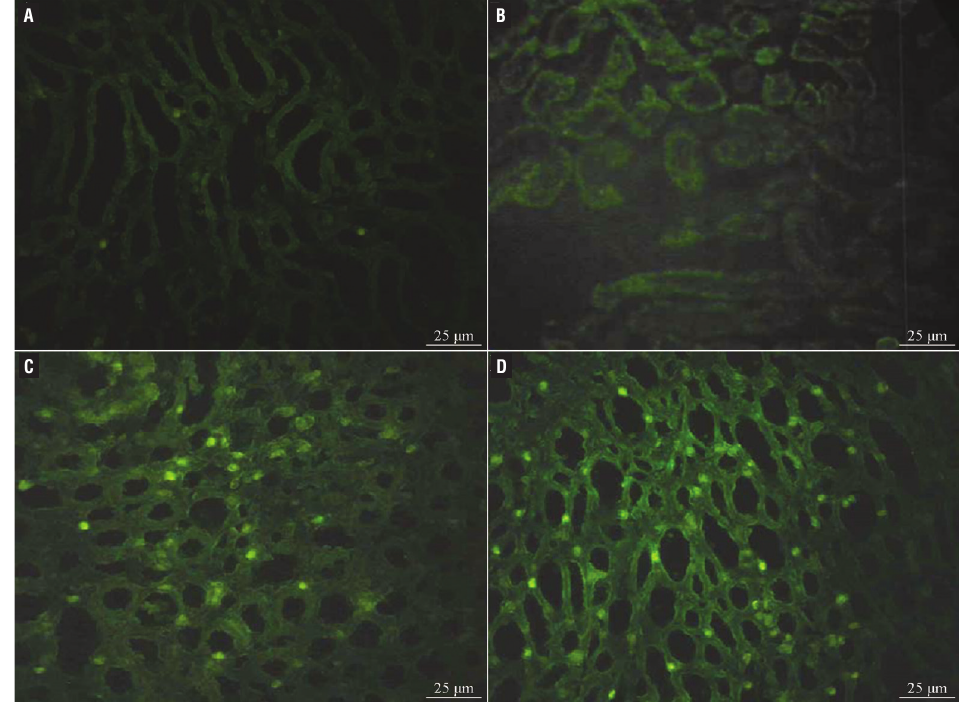
Table 3 - Ratio of positive eGFP-UCMSCs in renal tissue at different time in all groups (%). Group N 24 hours 48 hours Sham 10 0 0 I/R 10 0 0 UC-MSCs 10 9.8 ± 1.2 # 21.2 ± 7.3#* Note: #p < 0.005 vs. sham and I/R group; *p < 0.01 UC-MSCs+I/R 48 hours vs. UC-MSCs+I/R 24 hours I/R